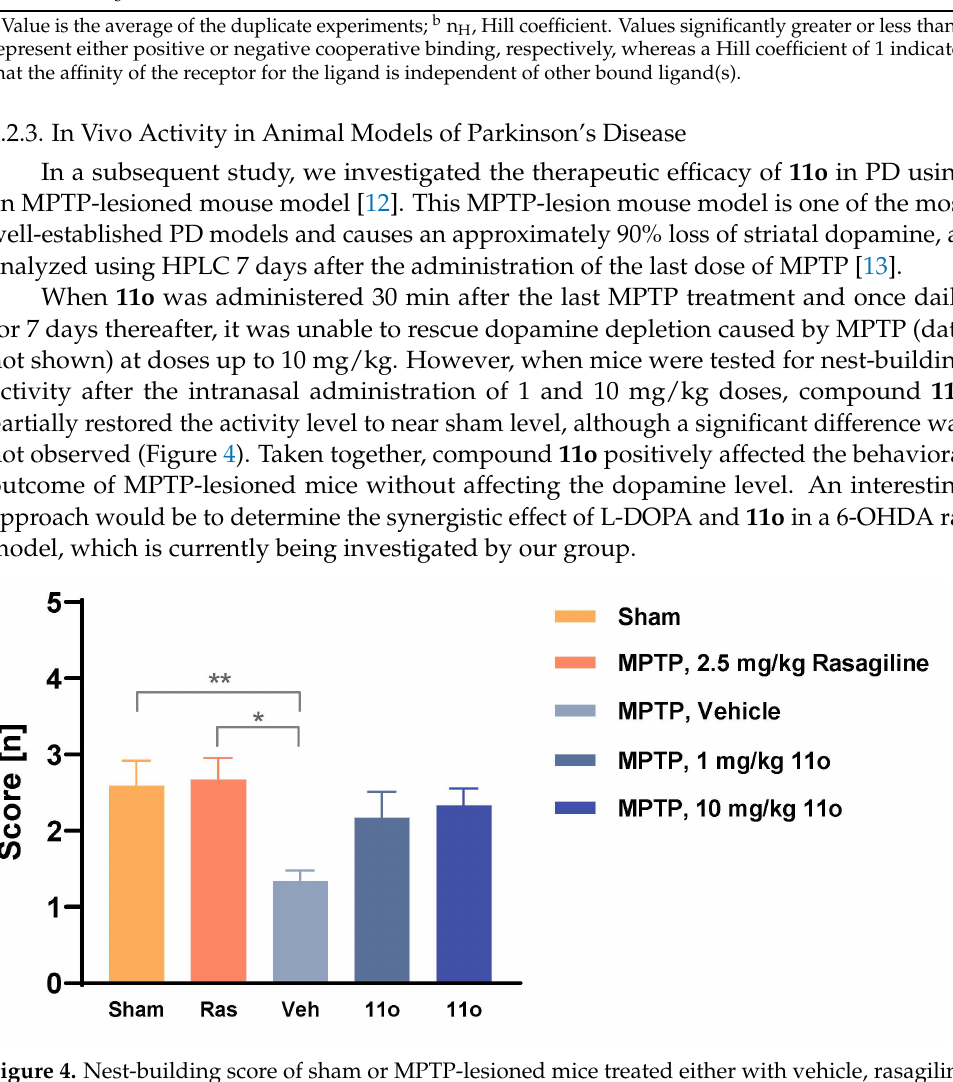
Figure 4. Nest-building score of sham or MPTP-lesioned mice treated either with vehicle, rasagiline or compound 11o (intranasal). The graph presents the mean nesting scores ± SEM ( n = 12 rats